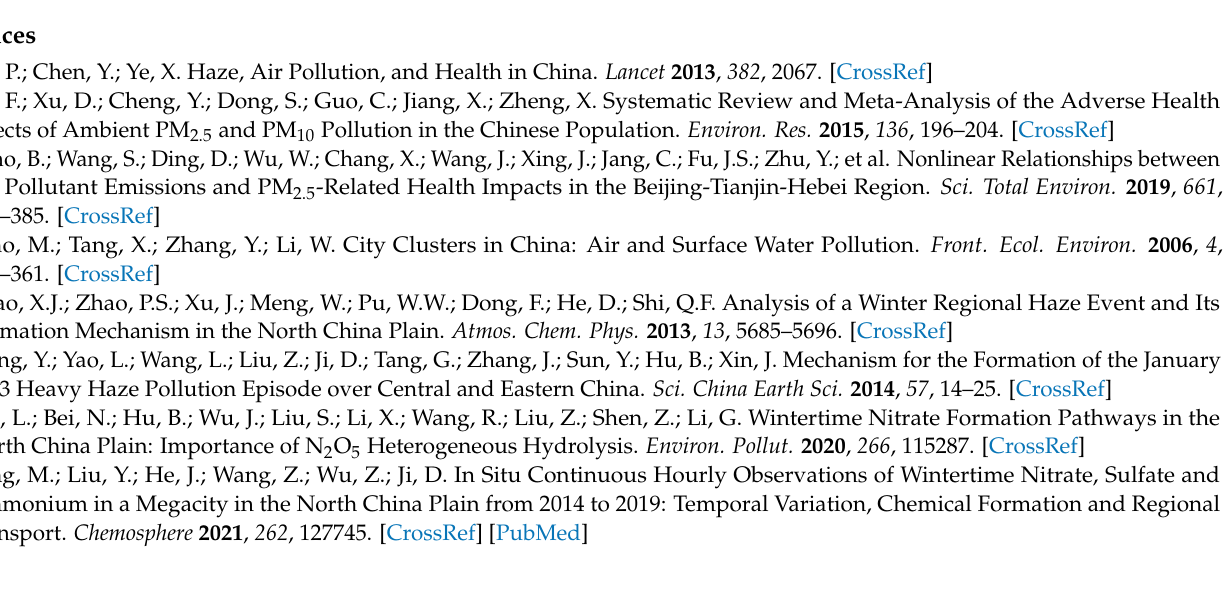
Figure S3: The spatial distribution of PM2.5 average annual concentrations in the NNCP region from 2015 to 2018, Figure S4: Elbow method for determining the number of clusters based on Euclidean distance (a) and Pearson’s correlation distance (b), Figure S5: The city-clusters with their average PM2.5 concentrations and ρ values for the s third-level in seasons (a): Autumn, (b): Winter, (c): Spring, Figure S6: Topographic map and winds rose diagrams of some cities for the winter of in 2018 in the NNCP region, Table S1: The COD values for six sub-regions based on Euclidean distance clustering, Table S2: The COD values for six sub-regions based on Pearson’s correlation distance